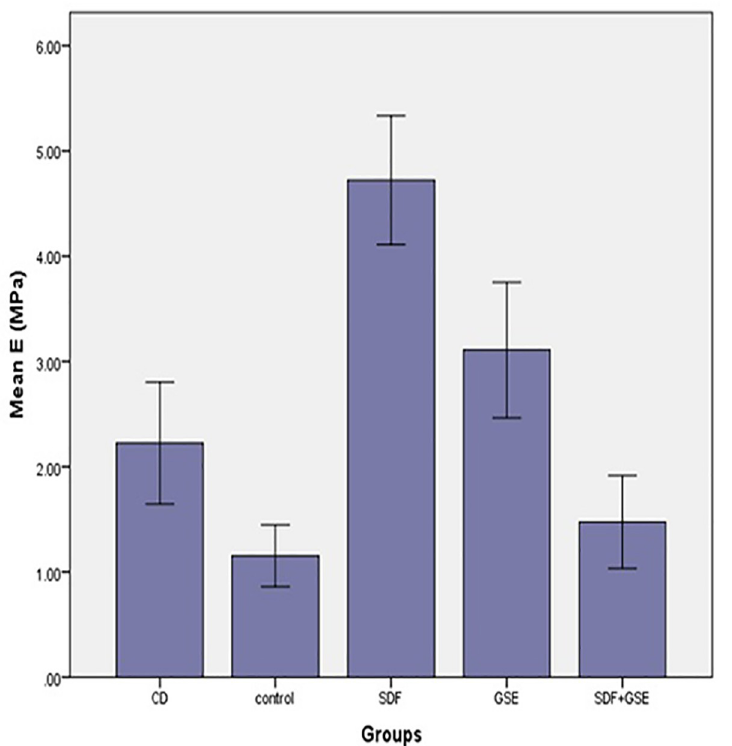
Fig 1. Difference in hardness (H1-H0) in the study groups.